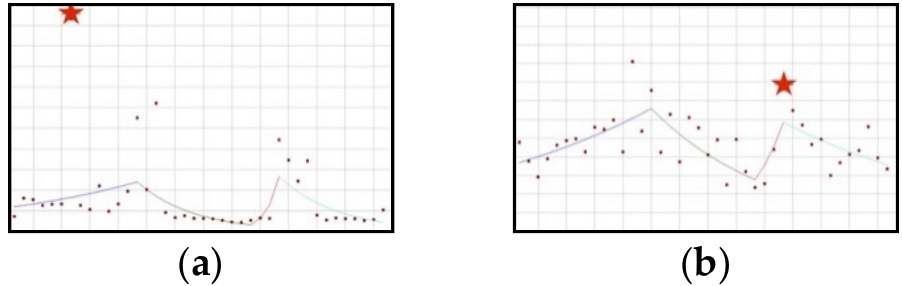
Figure 9. A schematic graph of the frequency of use of the ingredients in the respective quarters in the period from the first quarter of 2012 to the fourth quarter of 2021. The star denotes the moment of publication of a scientific opinion or a resolution concerning the ingredient. The height of placement of the symbol reflects the level of use of the ingredient. ( a ): Yohimbine (Figure A35); ( b ): Beta-alanine (Figure